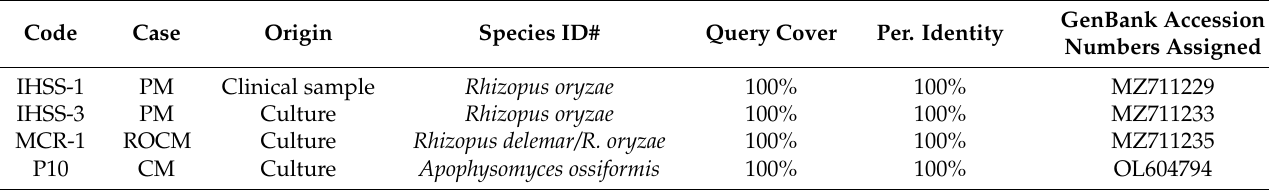
Table 1. Mucormycosis-producing species identified in this study and accession numbers assigned to